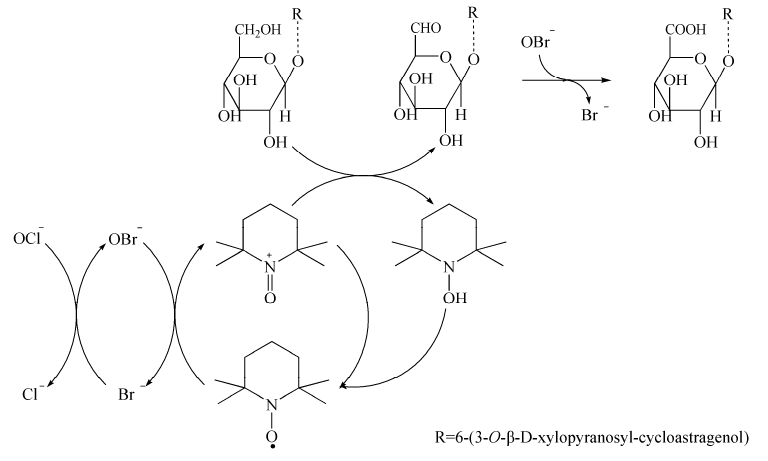
Figure 1. Proposed reaction mechanism for the formation of compound 1 .